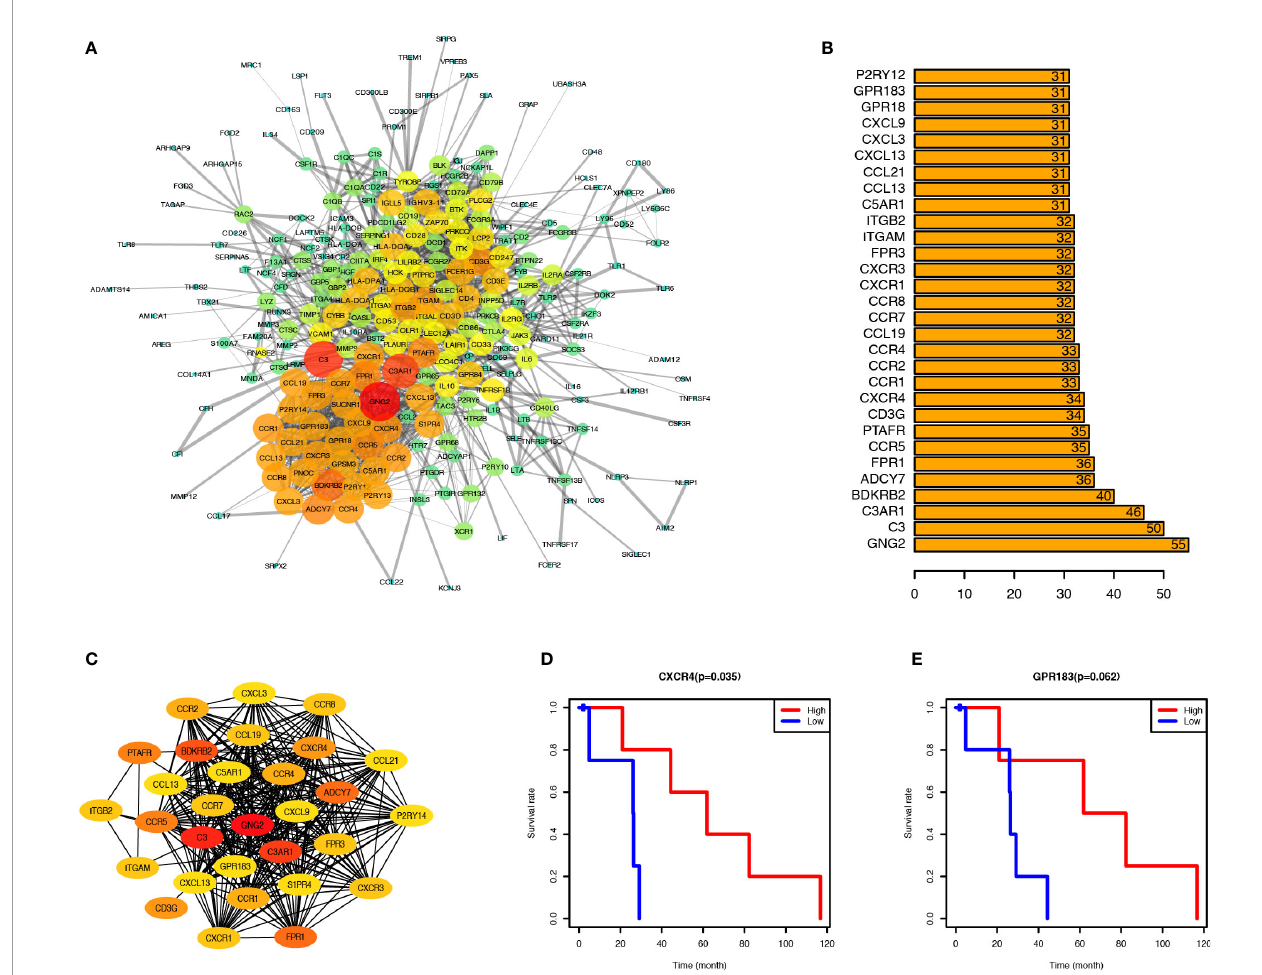
FIGURE 3 | CXCR4 and GPR183 were hub genes from the Interaction Network of upregulated genes, and associated with PCa prognosis. (A) Protein-Protein Interaction Network (CI=0.90) based on the upregulated genes, and the size and color of node indicate the connection degree. (B) Top 30 hub genes calculated by the connection degree of each node. (C) Interaction Network of top 30 hub genes. (D) PCa patients were divided into two groups according to the CXCR4 expression level, and the survival rate of these two groups indicated the PCa patients with higher CXCR4 expression level have better prognosis ( P = 0.035). (E) Similarly, the PCa patients with higher GPR183 expression level have better prognosis, although it was not signi fi cant ( P =